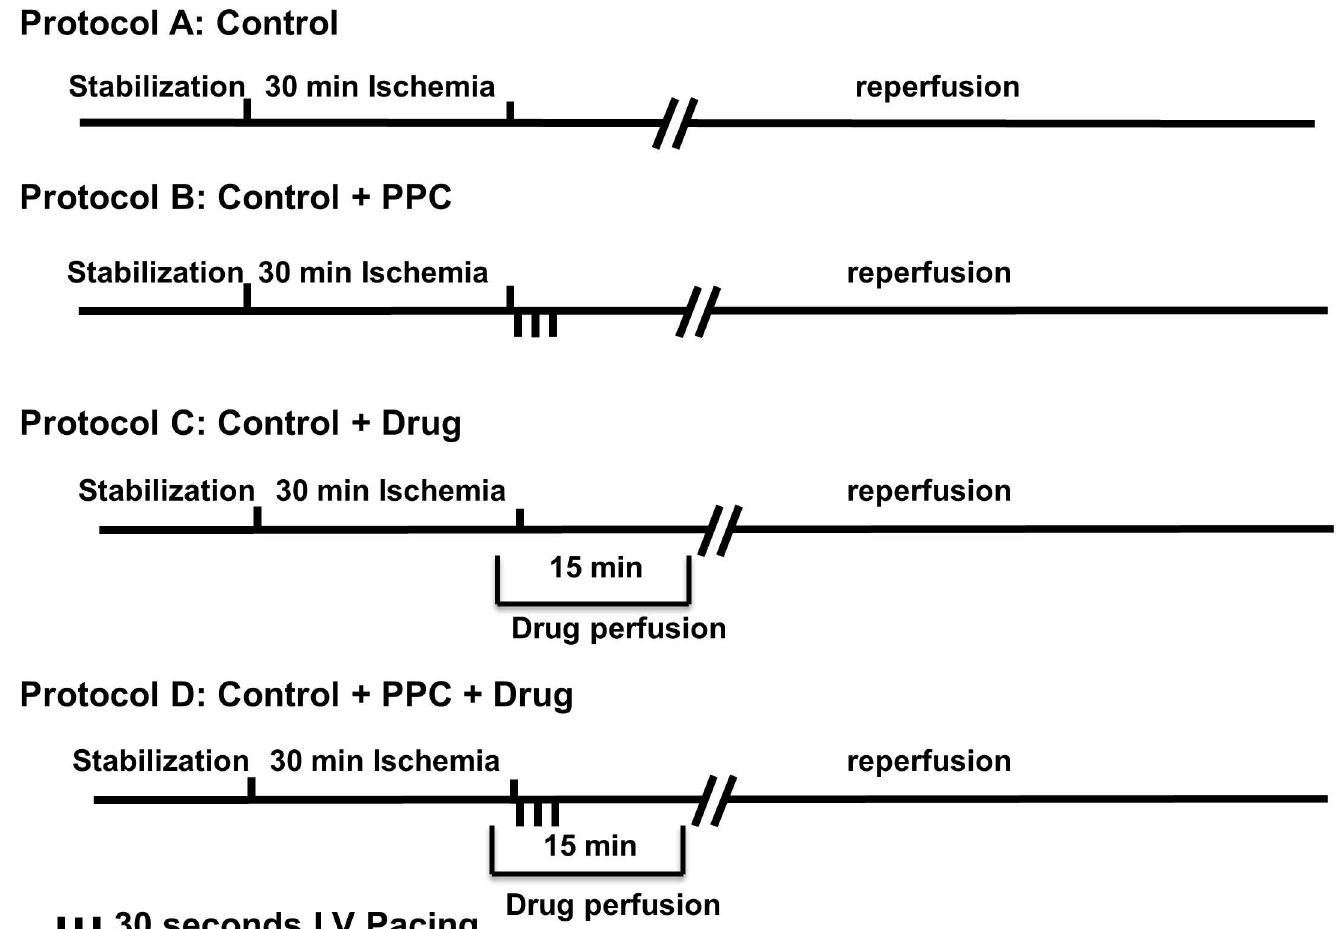
Fig 1. Schematic representation of the experimental protocols used in the study. Hearts isolated from Wister rats were subjected to one of the followingprotocols (n = 8 hearts per treatment). (A) Unprotected ischemia-reperfusion (control). (B) Ischemia and PPC started immediately at the start of reperfusion. (C) Ischemia and drug dosed 5 min before the start of reperfusionin absence of PPC. (D) Ischemia in presence of PPC and drug dosed 5 min before the start of reperfusion. LV, left ventricle; PPC, pacing postconditioning.